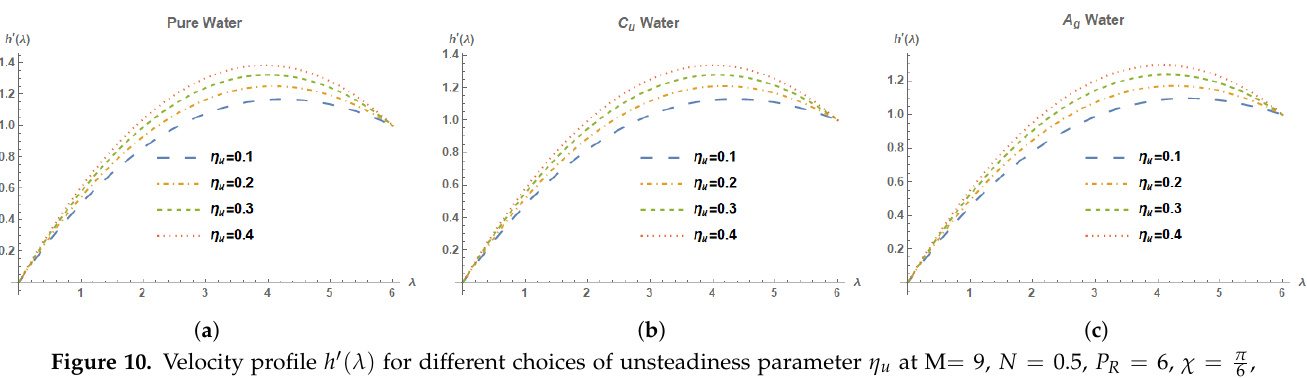
Figure 10. Velocity profile h (cid:48) ( λ ) for different choices of unsteadiness parameter η u at M = 9, N = 0.5, P R = 6, χ = π τ = 0.6, Γ = 2, ε = 1, C T = 0.1, S = 1 showing their exciting nature. ( a ) pure-water. ( b ) Cu-water. ( c )